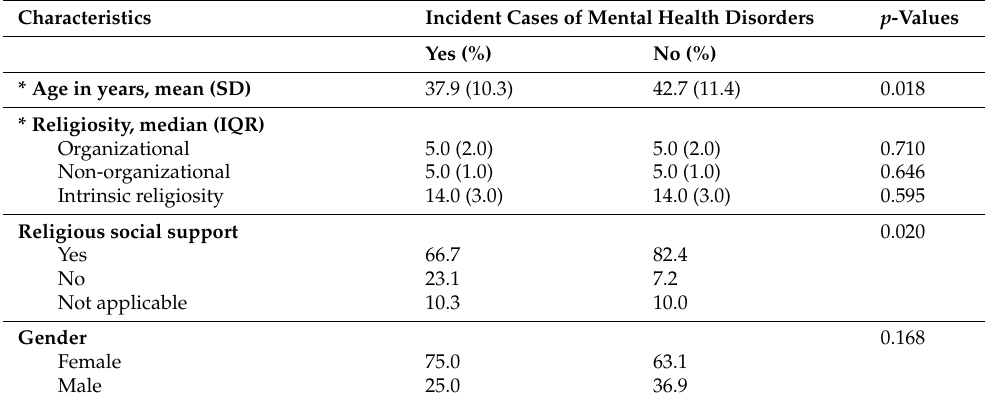
Table 2. Determinants of Incident Mental Health Disorders, African Immigrant COVID-19 Study 2021.